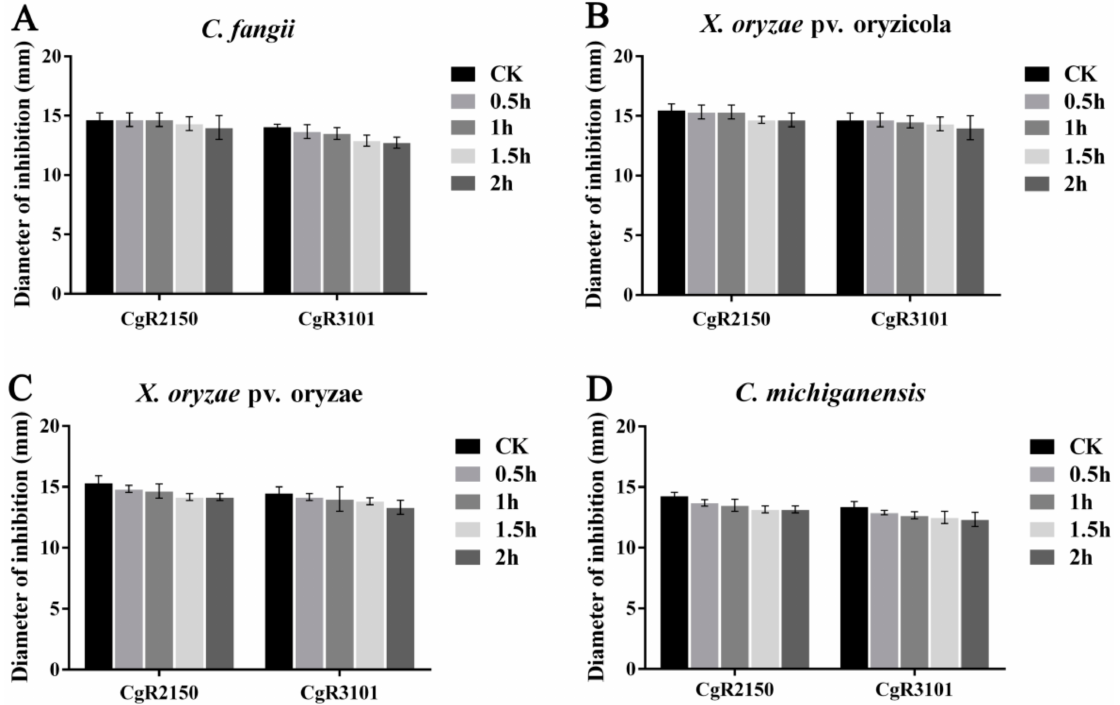
Figure 6. UV stability tests of CgR2150 and CgR3101. Antimicrobial peptides without UV treat- ment were used as controls. ( A ) C. fangii , ( B ) X. oryzae pv. oryzicola, ( C ) X. oryzae pv. oryzae, and ( D ) C. michiganensis are the antibacterial activity of the two peptides under UV treatment at different times (0.5 h, 1 h, 1.5 h, and 2 h). The data are the mean values obtained after three independent exper- iments, and the vertical bars are the standard deviations (SD). Significance analysis was